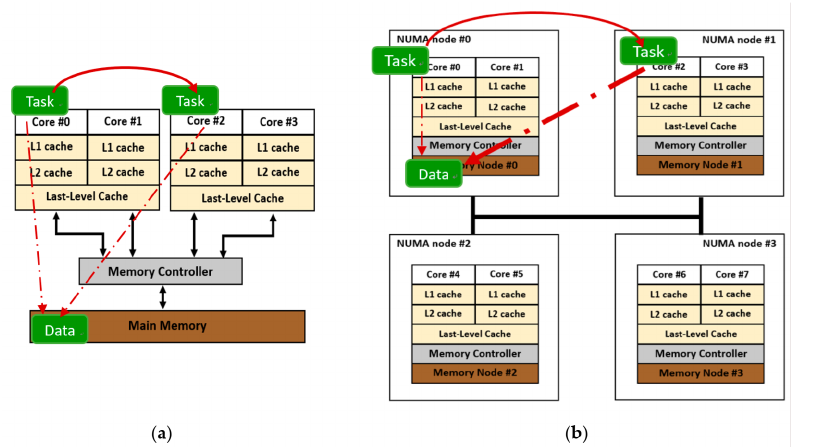
Figure 1. The load balancing mechanism affects SMP and NUMA systems differently. ( a ) SMP system; ( b ) NUMA